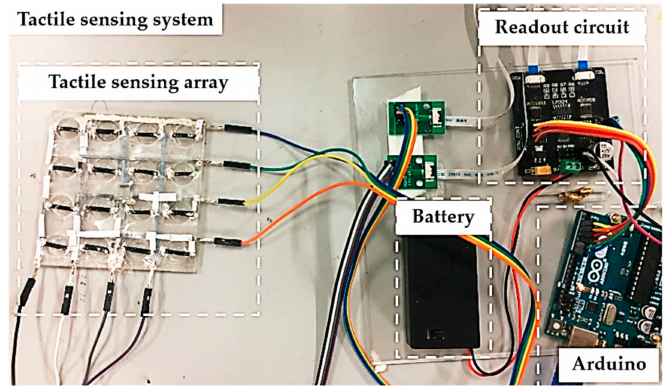
Figure 7. Photograph of the hardware configuration for the flexible tactile sensing